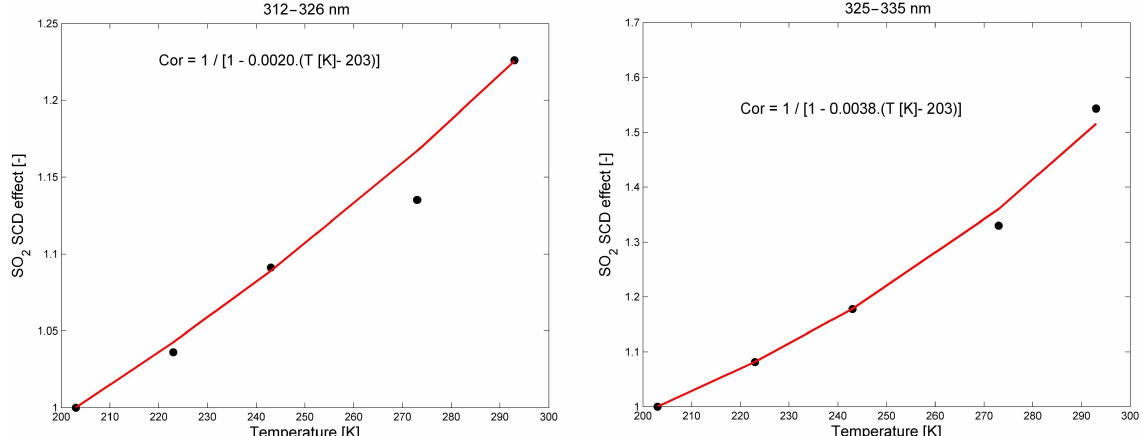
Figure 6. Effect of temperature (relative to 203K) on SO 2 retrieved SCD for fitting windows 312–326 (left) and 325–335nm (right). The red lines show the adopted formulation of C temp (Eq. 10). Note that, for the 312–326nm window, the result at 273K has been discarded from the fit as it is seems rather inconsistent with the dependence at other